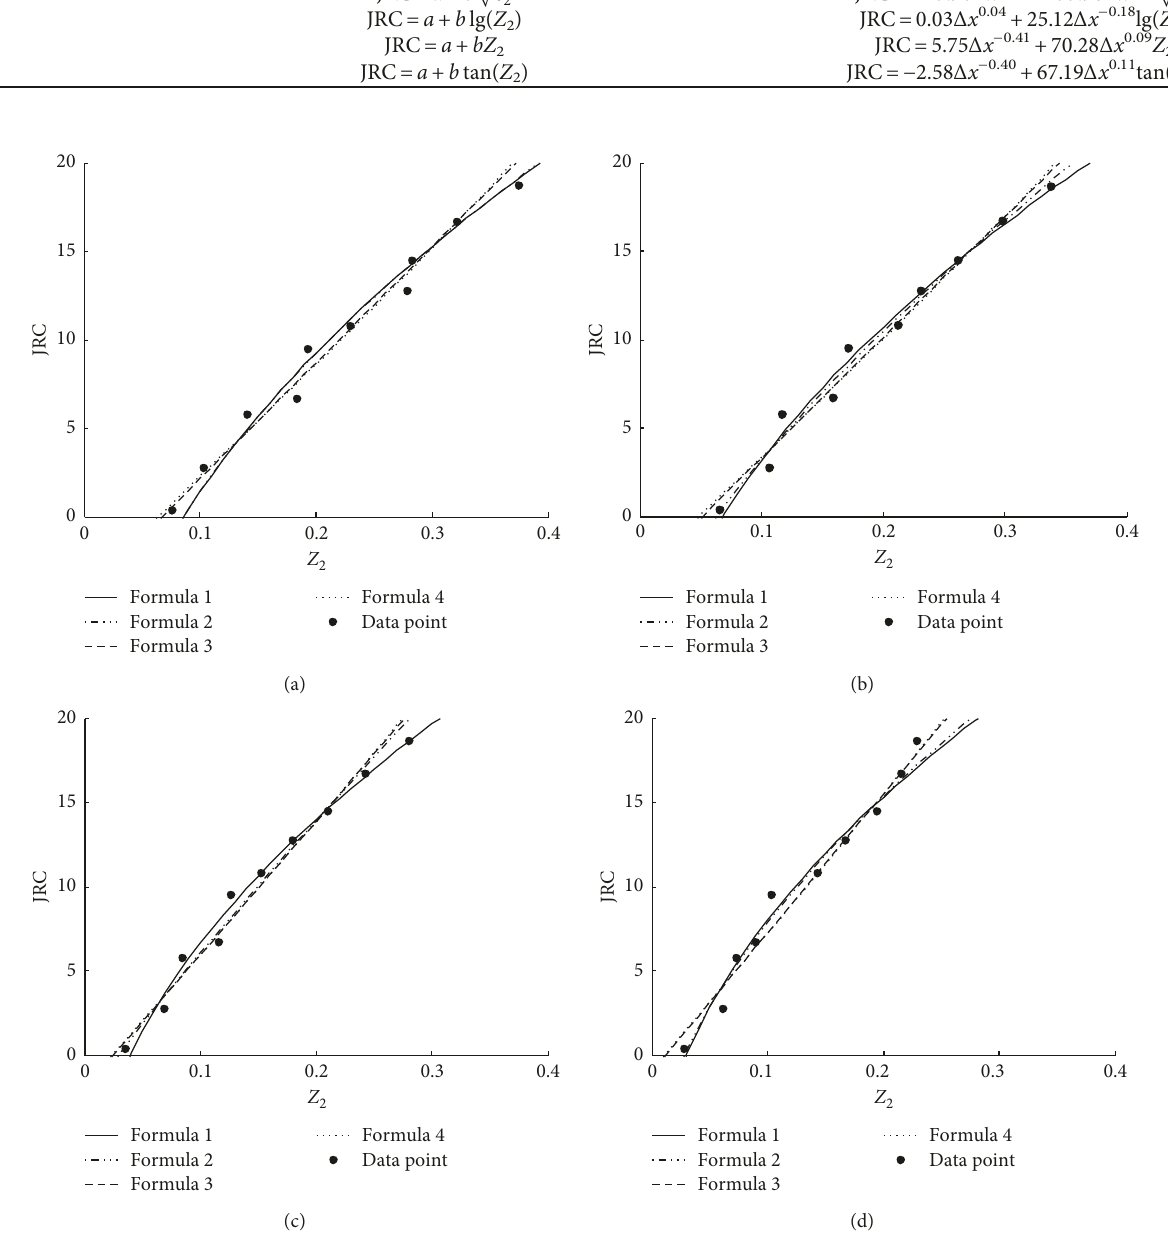
Figure 10: Comparison of the empirical equations for JRC– Z